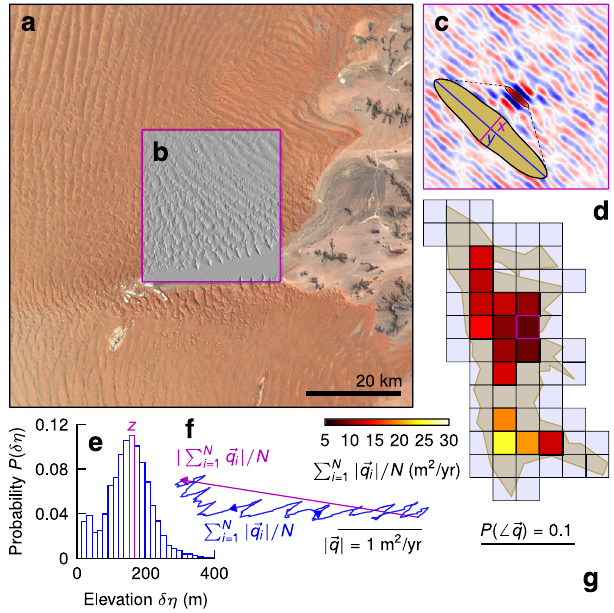
Fig. 1 Extraction of dune geometry and sand fl ux. a LANDSAT imagery of part of the Namib Sand Sea, one dune fi eld in the dataset. b Hillshade SRTM topography from an example 32 2 -km 2 tile. c The high-pass autocorrelation of the topography in b overlaid by the extracted characteristic planform dune geometry in black (zoomed inset in yellow de fi nes wavelength x in magenta and width y in blue). d Grid of prospective tiles intersecting the dune fi eld (yellow); tiles included in the dataset (where dune geometry can be measured) are colored by mean sand fl ux j q ! j inferred from ERA5 10-m winds. e Probability distribution of local relief δη found by convolution of SRTM topography with a min-max box of width x ; the peak marks the characteristic dune height z . f Time-means of the resultant sand fl ux vector (magenta) and cumulative sand fl ux vectors (blue) for b ; terms denote their lengths, and arrows their directions. g The probability distribution of sand fl ux directions for b . Black lines denote scale in a , f & g , N is the number of hourly measurements over the decade of ERA5 reanalysis, north is up in a – d , f & g , and magenta boxes in b – d outline the common